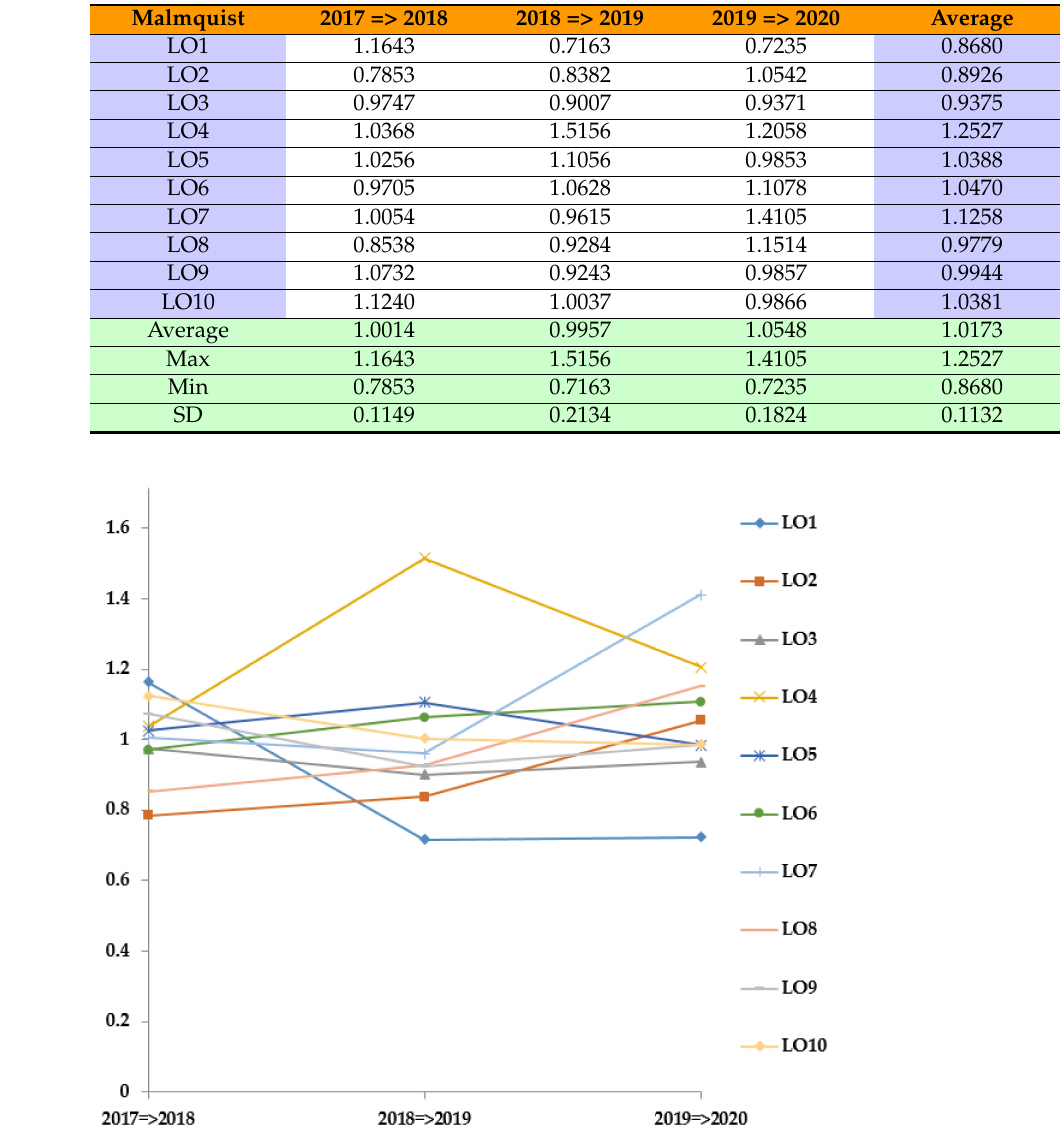
Figure 11. Malmquist results (source: